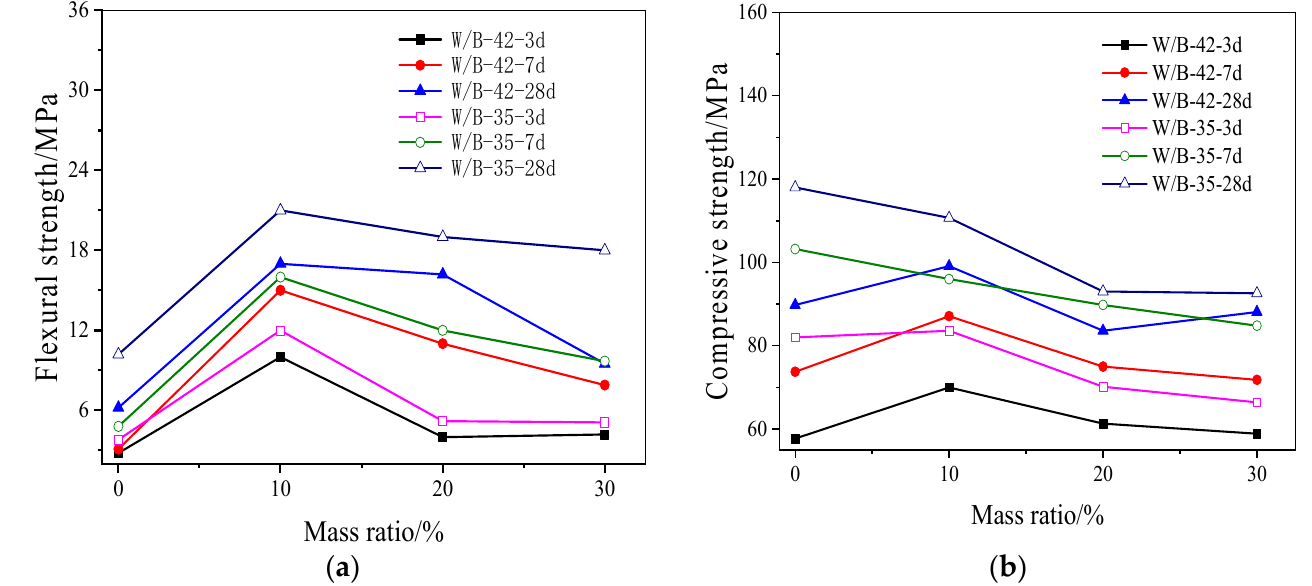
Figure 5. The mechanical strengths of activated blast furnace slag powder with CaO. ( a ) Flexural strength. ( b ) Compressive strength.